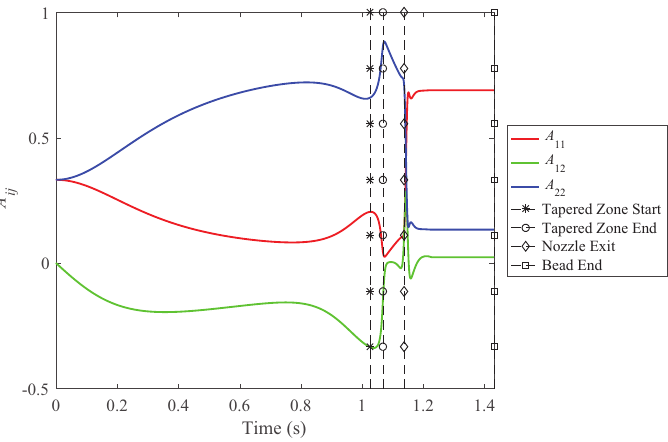
Figure 3. Components of A ij , predicted with the IRD model with C I = 10 − 2 , along streamline